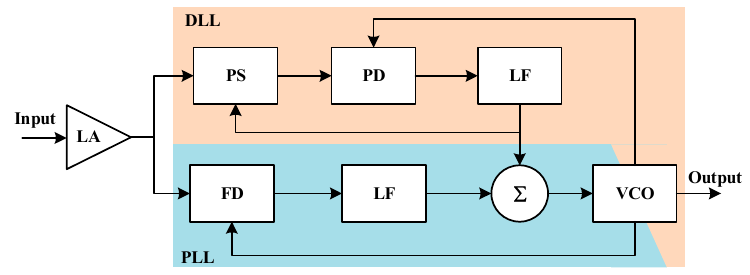
Figure 6. Schematic of the DSR module.